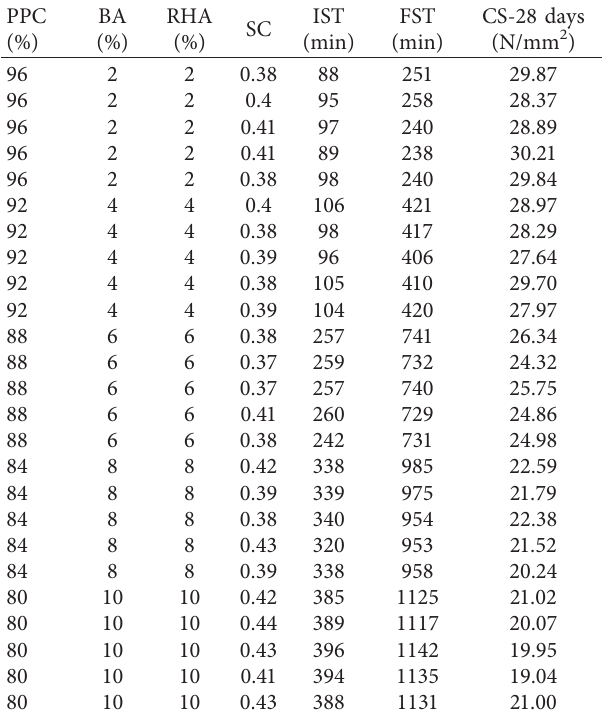
Table 3: Training dataset for ANN3 (BA +RHA) replacement.